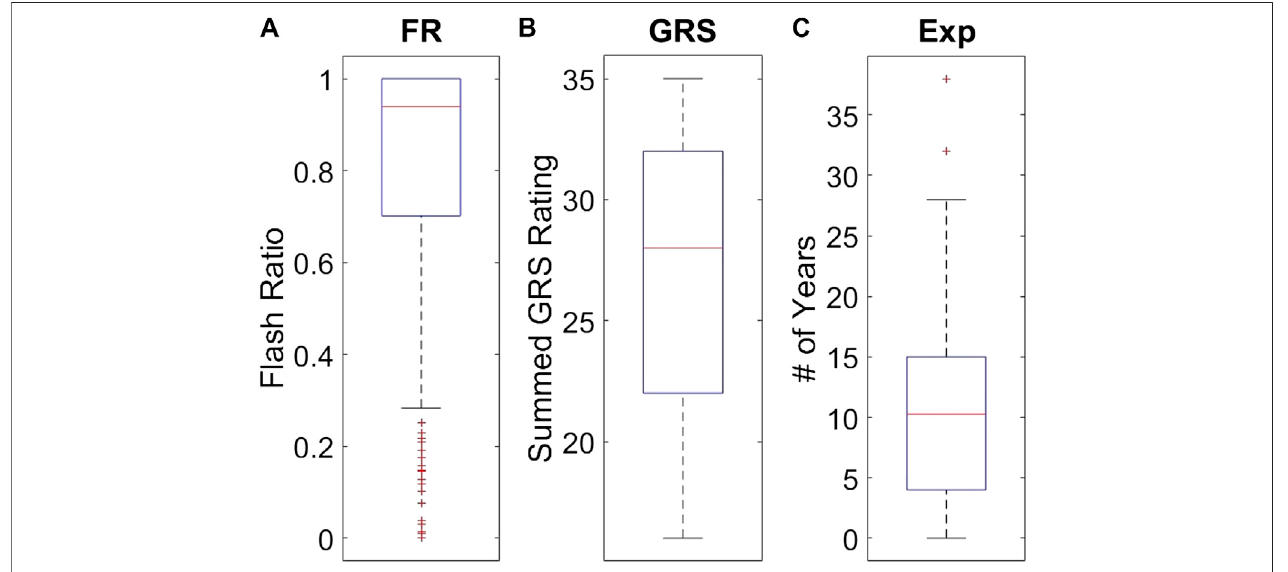
FIGURE5| Individualdistributionsofeachskillindicatormetric.Subplot (A) shows thedistribution of FR valuesobserved amongthe779trials.Subplot (B) shows the distribution of the 49 GRS participant values. Subplot (C) shows the distribution of 49 Exp values for the participants.